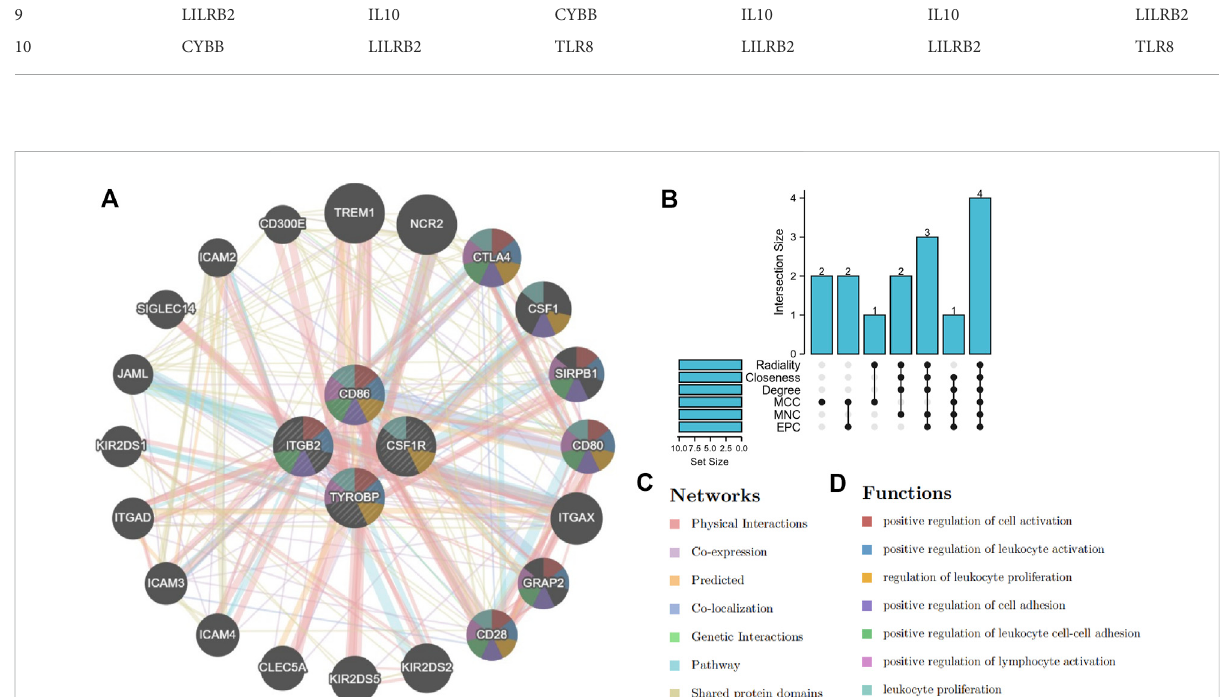
FIGURE 7 Selection and co-expression network of hub genes. (A) co-expression network of hub genes. (B) screening hub genes based on six algorithms. (C,D) function analysis and networks of hub genes and their co-expression